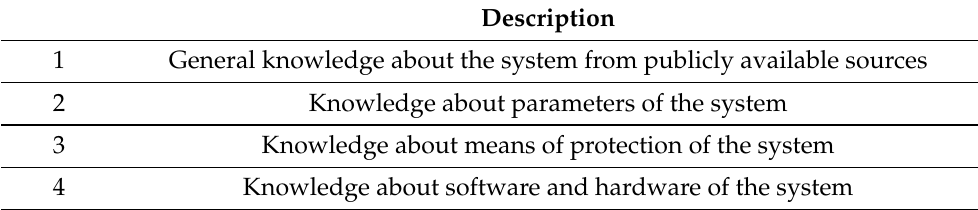
Table 3. Attacker types of knowledge.